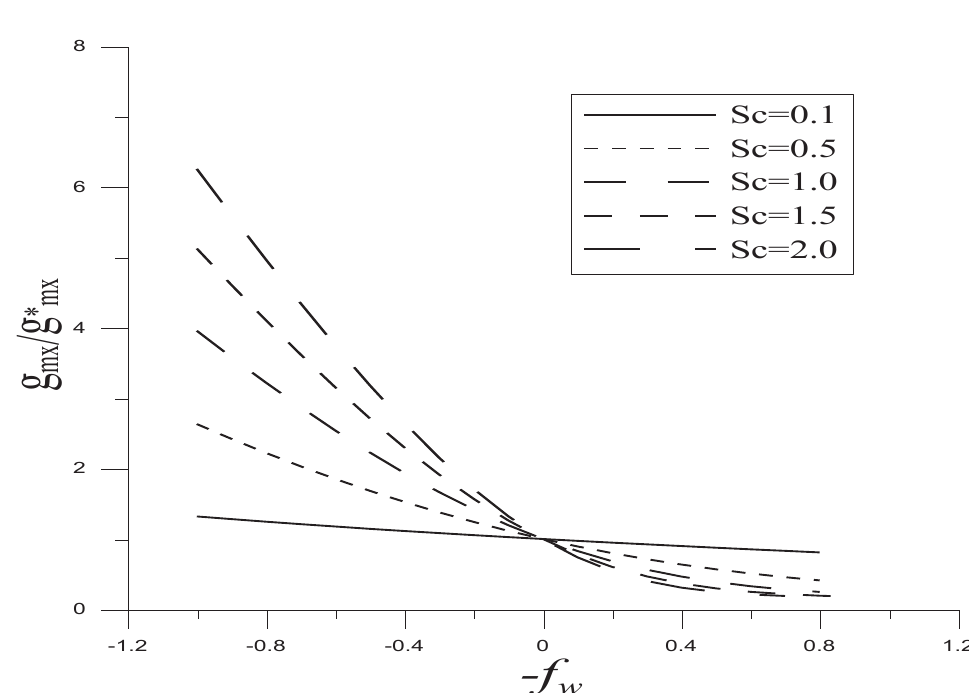
f at (cid:91) = 1.0, n = 1.0, N = 1.0, (cid:74) = 2.01, (cid:72) = 0.45, w